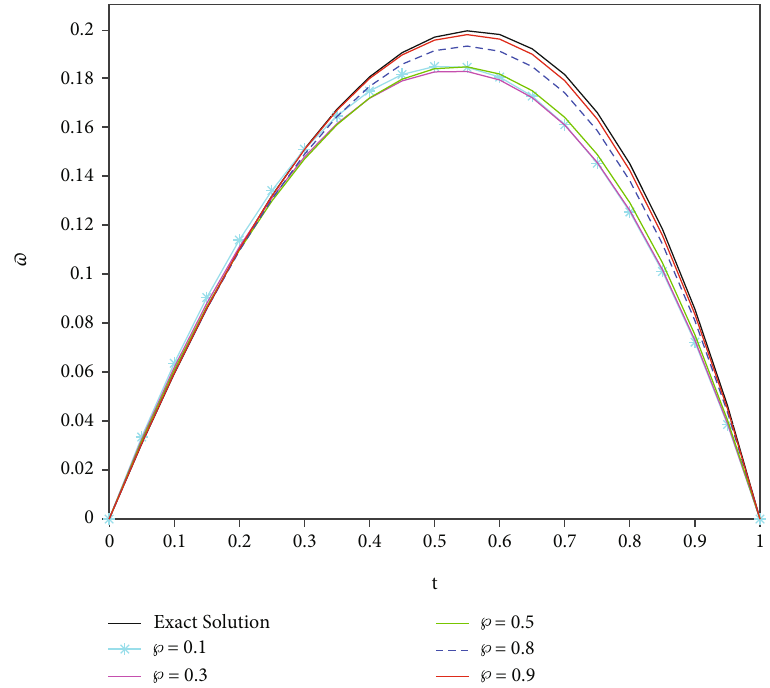
Figure 7: Exact and approximate solution for Example 10, when θ = − 1